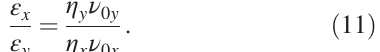
x ð y Þ at each